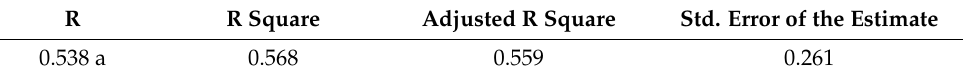
Table 11. Model Fitness.